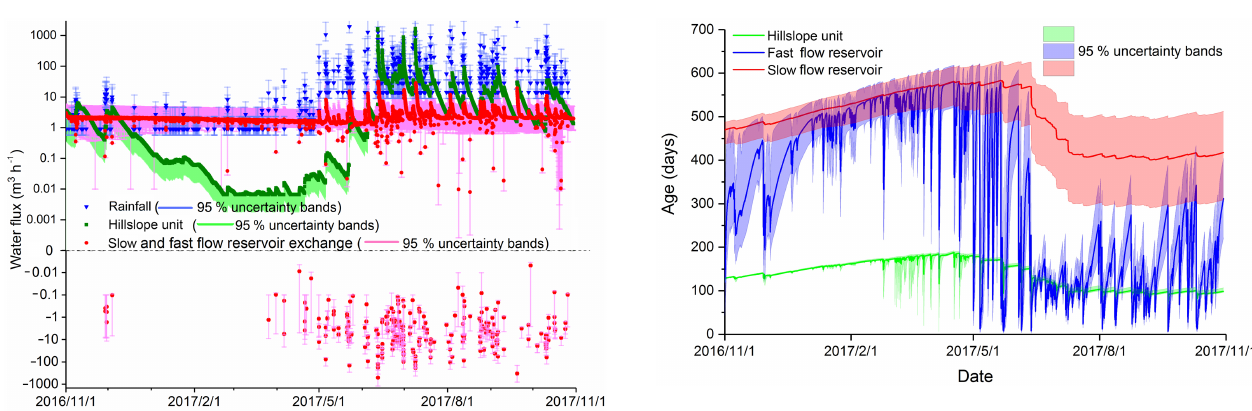
Figure 10. Mean of water flux age of hillslope and fast and slow reservoirs (for the 500 best parameter